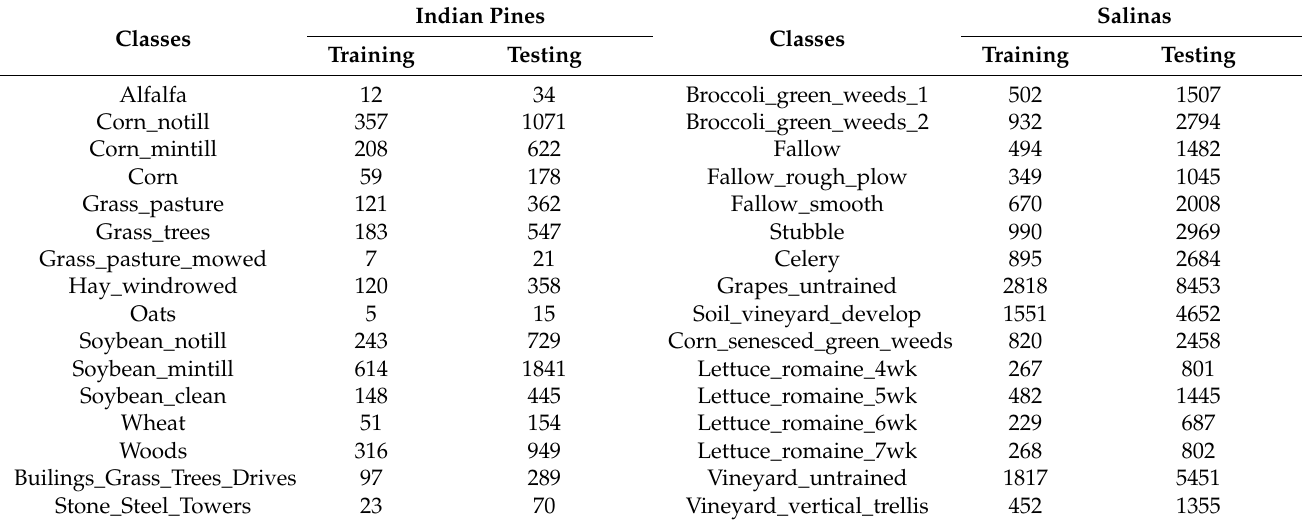
Table 2. Training and testing samples used in Indian Pines and Salinas datasets.